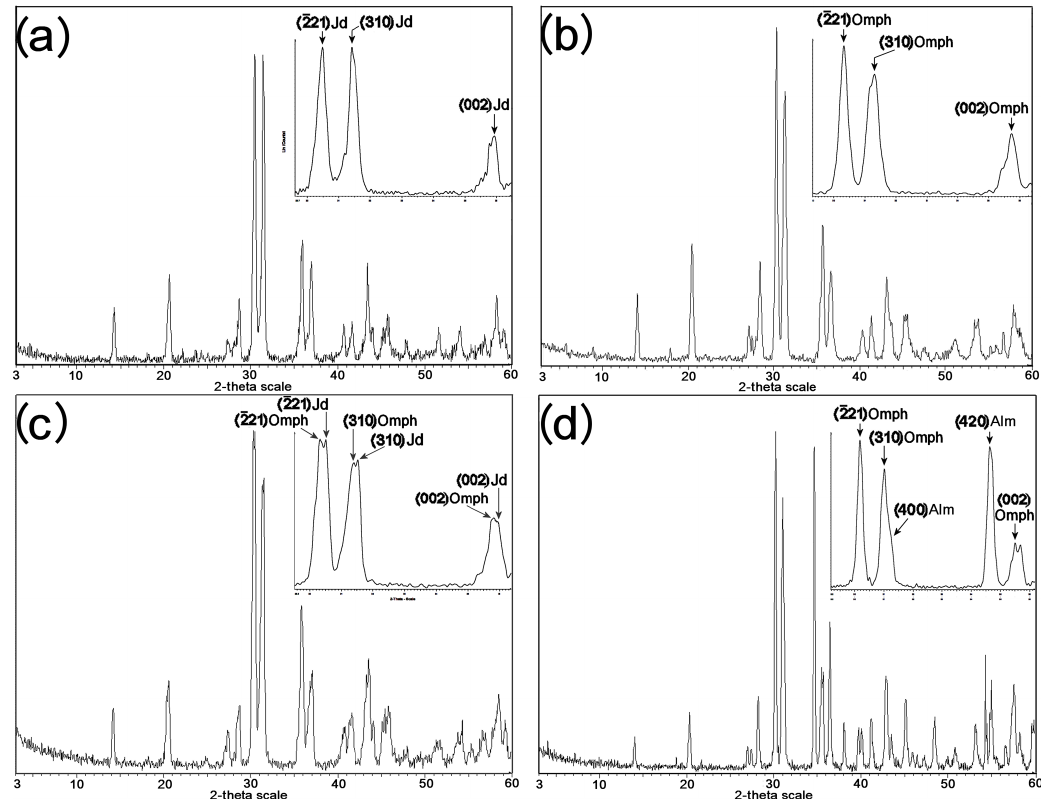
Figure 4. X-ray powder diffraction patterns of selected tools from Chiomonte. In jadeitite ( a : 3788) and omphacitite ( b : 6602), the character- istic reflections of clinopyroxenes ( − 221, 310 and 002; see the magnifications in the upper right corners of each panel) are sharp and mostly singular. In mixed Na pyroxenite ( c : 7179), the coexistence of both jadeite and omphacite in almost equal amounts splits them into two partially superposed peaks. In eclogite ( d : 67142/8936), reflections of garnet (i.e. almandine) also appear. (Jd, jadeite; Omph, omphacite; Alm, almandine; Cu– Kα